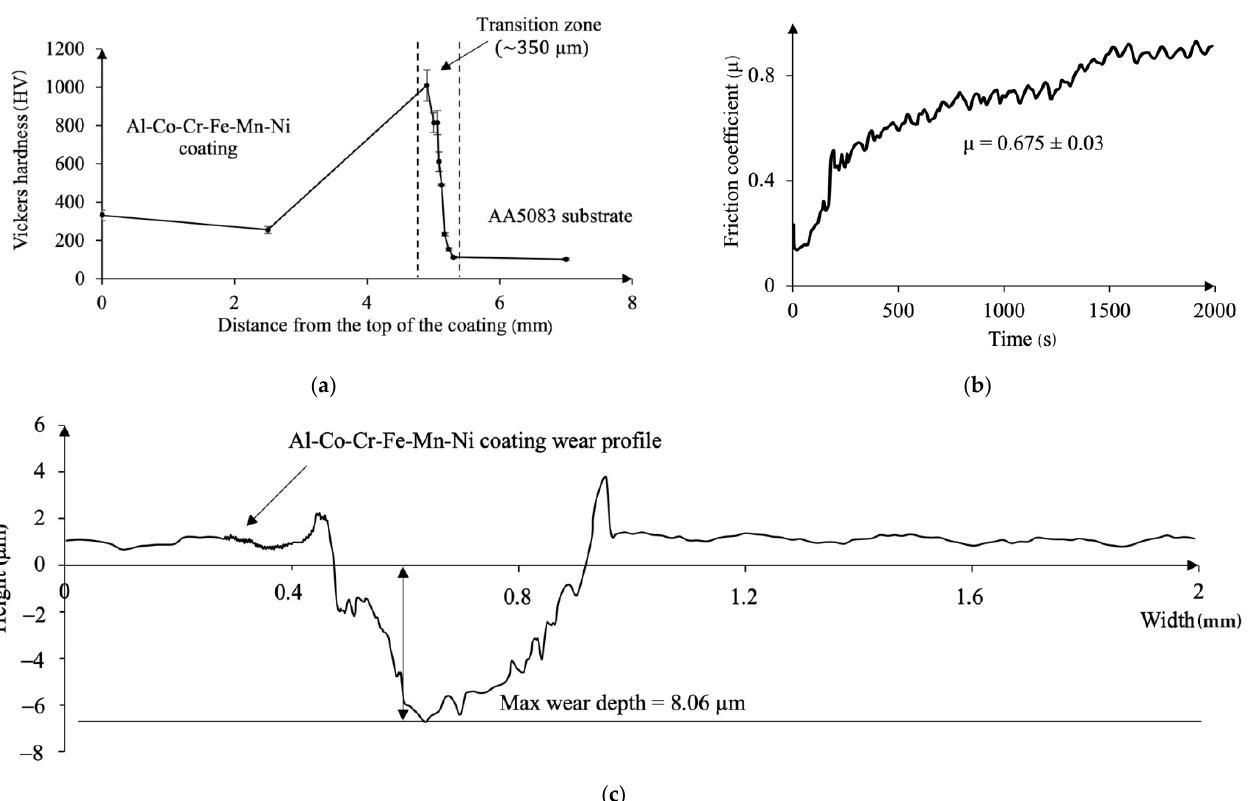
Figure 5. ( a ) Variations of Vickers hardness values across the coating and the substrate; ( b ) evolution of friction coefficient of the Al-Co-Cr-Fe-Mn-Ni coating during the test duration; ( c ) wear profile of Al-Co-Cr-Fe-Mn-Ni coating after tribological test.